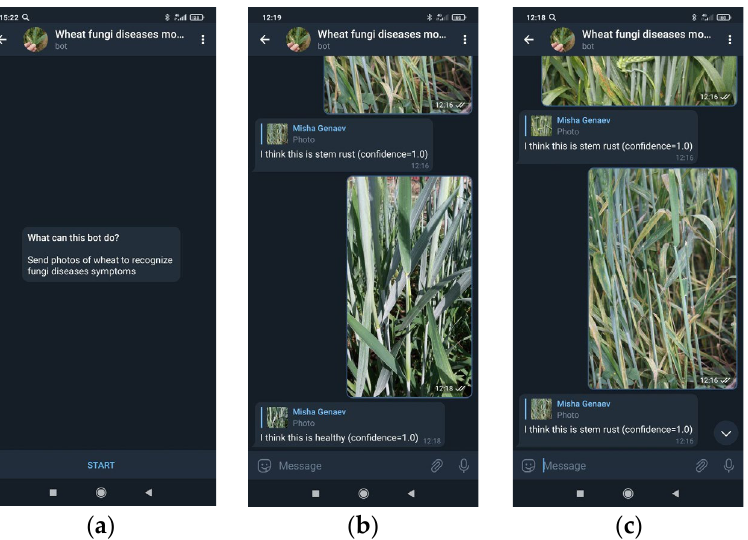
Figure 11. User interface for interacting with the bot @wheat_healthy_bot in the Telegram messenger: ( a ) begin dialogue; ( b ) example of image classification, healthy plant; and ( c ) example of image classification, stem rust.